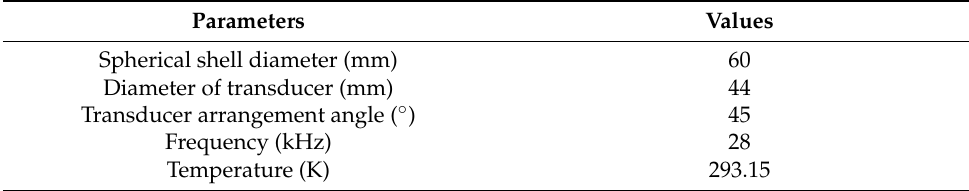
Figure 2. Physical model of simulation. Table 1. Main parameters of simulation. Table 1. Main parameters of simulation.